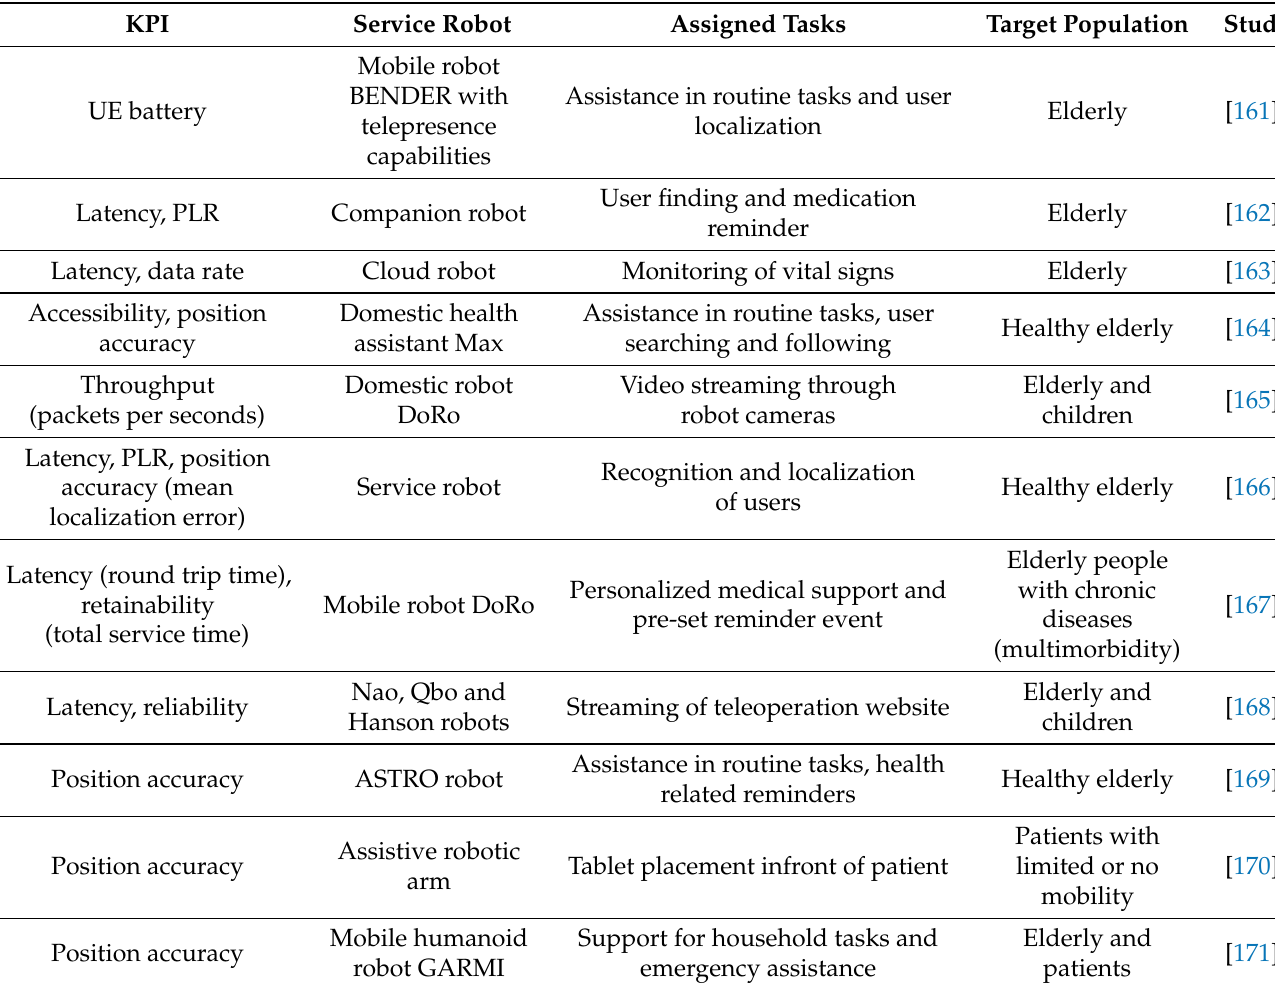
Table 2. Summary of literature for relevant assistive robots